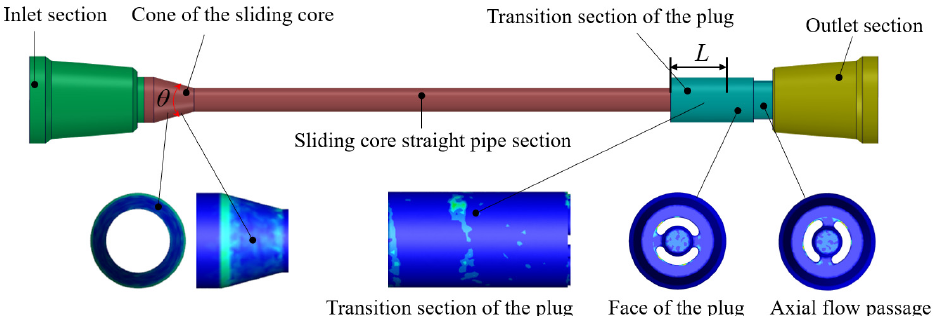
Figure 4. Erosion location distribution of PCIT.